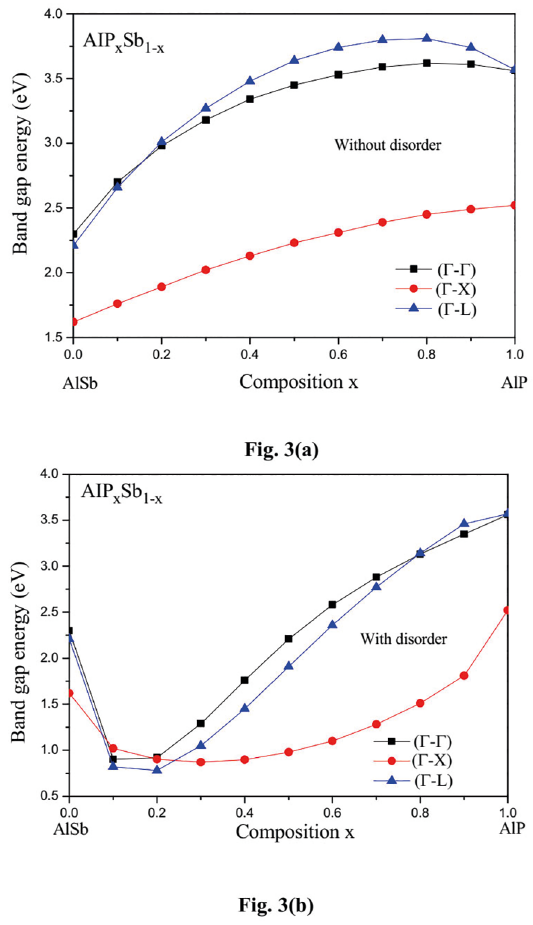
Figure 3. (a) . Direct (Γ-Γ) and indirect (Γ-Χ) and (Γ-L) band gap energies in AlP Sb ternary alloys versus P content calculated x 1-x without considering the compositional disorder effect. (b) . Direct (Γ-Γ) and indirect (Γ-Χ) and (Γ-L) band gap energies in AlP ternary alloys versus P content calculated with considering